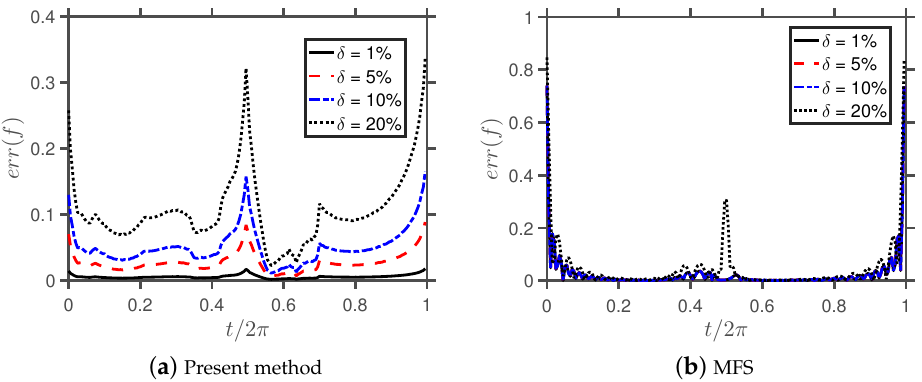
Figure 9. The relative errors of f obtained with various amounts of noise added in the boundary data on ∂ D